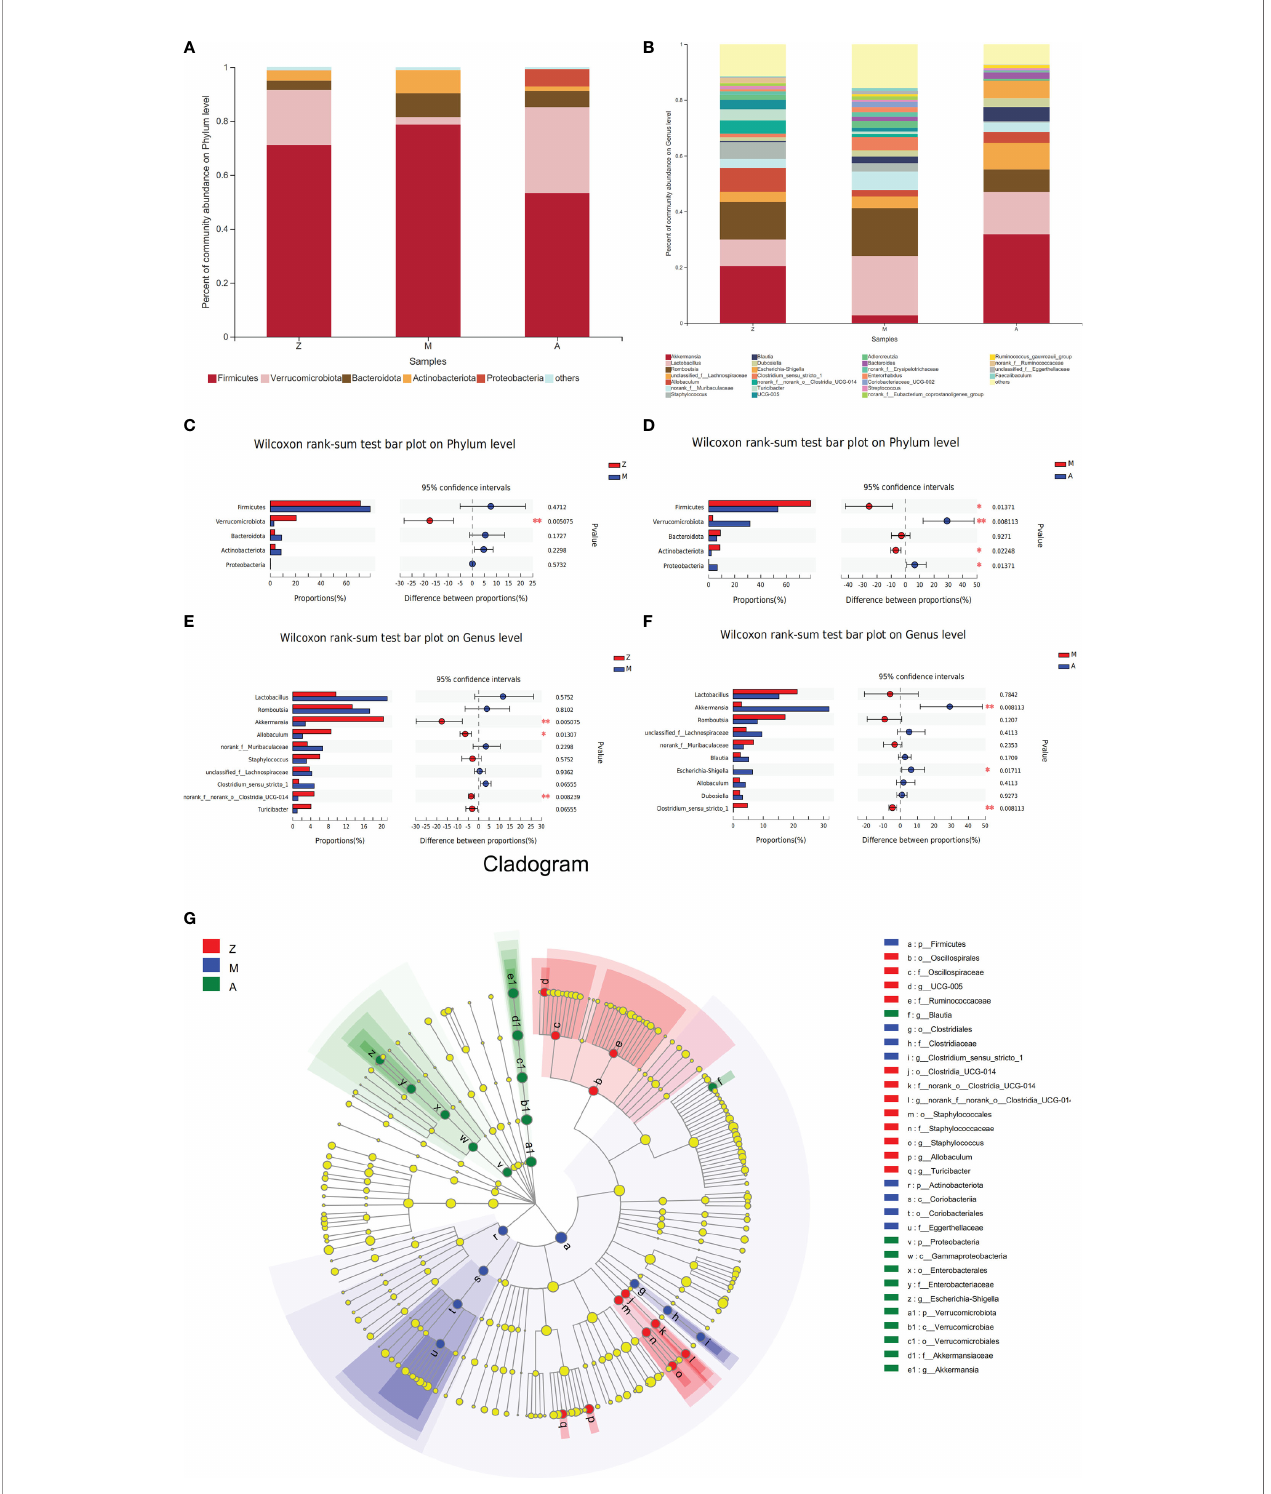
FIGURE 4 | Composition and difference analysis of intestinal microbiota at phylum and genus levels. Z, control group; M, model group; A, treatment group. (A) Percent of community abundance on Phylum level. (B) Percent of community abundance on Genus level. (C) The microbiota proportions ’ difference between Group Z and M on Phylum level. (D) The microbiota proportions ’ difference between Group M and A on Phylum level. (E) The microbiota proportions ’ difference between Group Z and M on Genus level. (F) The microbiota proportions ’ difference between Group M and A on Genus level. (G) Cladogram by Lefse analysis. * p < 0.05; ** p <